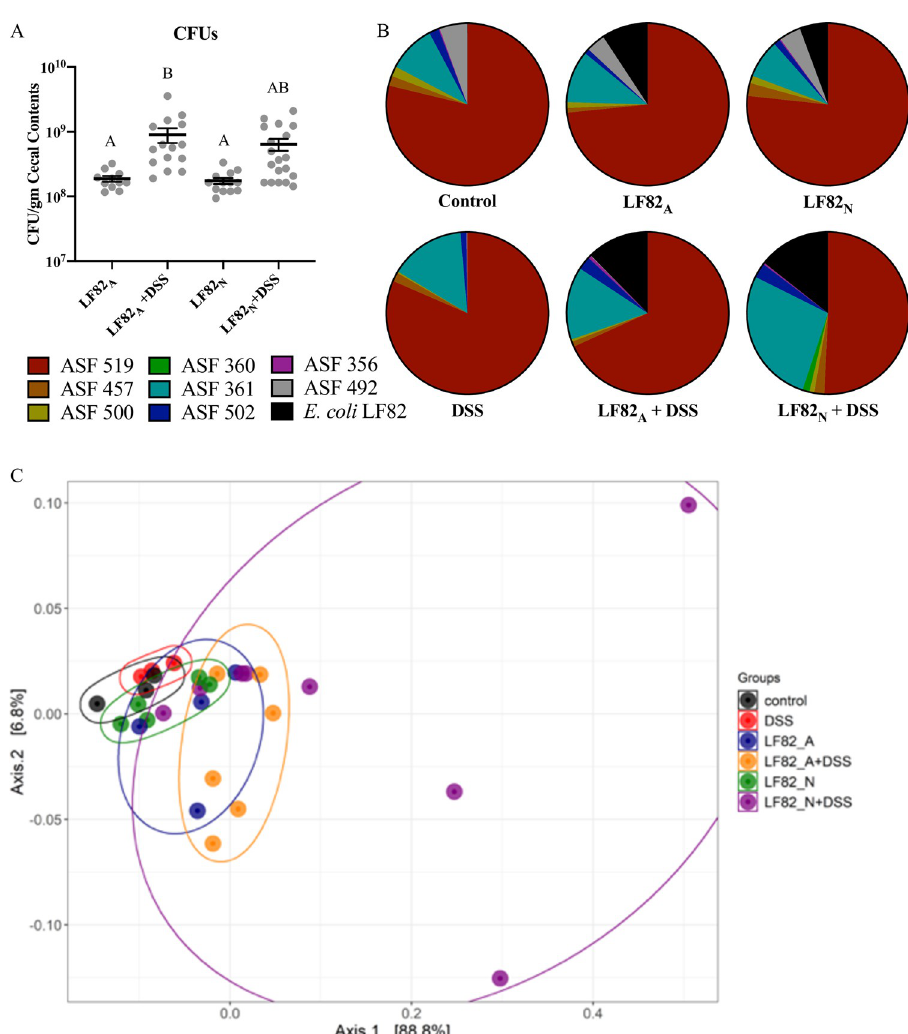
Fig 3. Evaluation of the luminal microbial community following E . coli LF82 colonization and/or DSS-induced inflammation. At necropsy, the cecal load of E . coli LF82 was enumerated by bacteriological culture ( A ), and 16s rRNA gene amplicon sequencing was performed on DNA recovered from fecal samples to assess relative microbial abundance ( B ). A Weighted UniFrac PCoA plot was generated using PhyloSeq to assess changes in beta diversity among the treatment groups ( C ). Each point represents a single animal, and each color represents a treatment group. The ellipses were generated to visualize the relative variability of each treatment group. Shared letters between different groups indicate no statistical significance with an ANOVA with multiple group comparisons test. A: LF82 A n = 11, LF82 A + DSS n = 15, LF82 N n = 13, LF82 N + DSS n = 19; B and C: Control n = 3, DSS n = 3, LF82 A n = 4, LF82 A + DSS n = 6, LF82 N n = 5, LF82 N + DSS n =